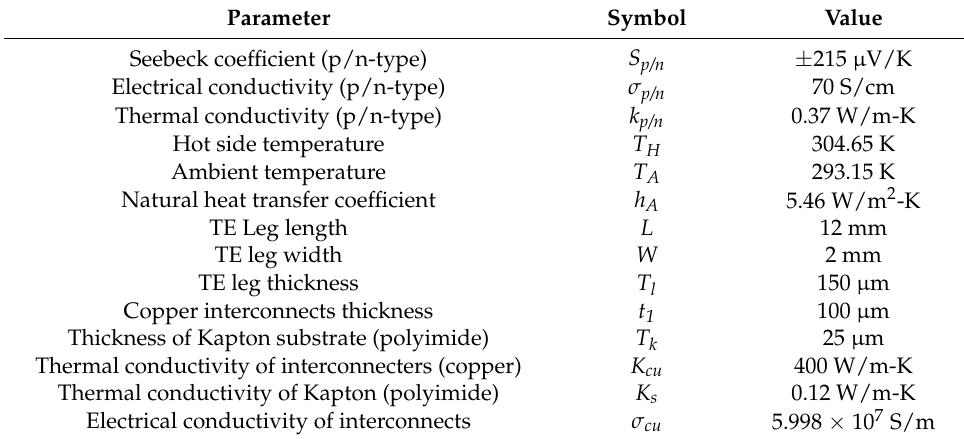
Table 1. Values for geometries, material properties, and boundary conditions.